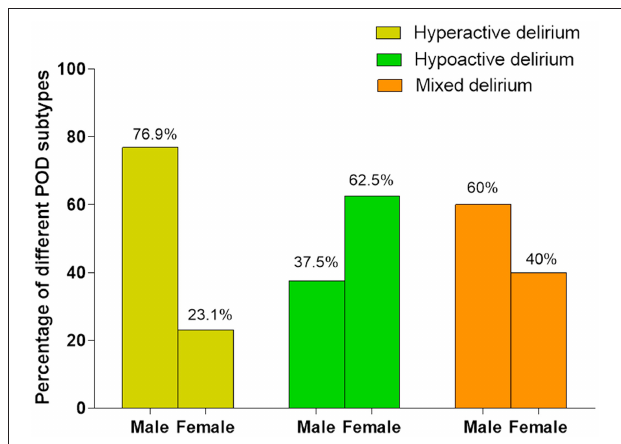
FIGURE 2 | The incidence of POD subgroups in males and